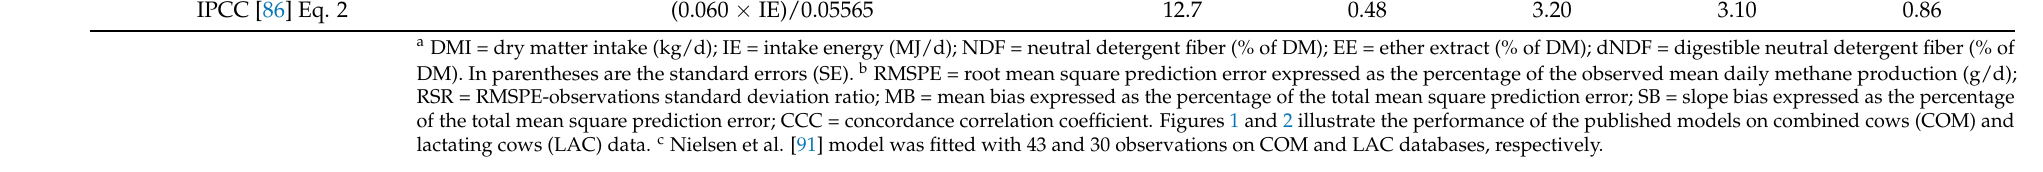
Table 5. Methane yield (g/kg DMI) prediction equations and literature published, and model performance evaluation for combined (COM) and lactating cows (LAC)